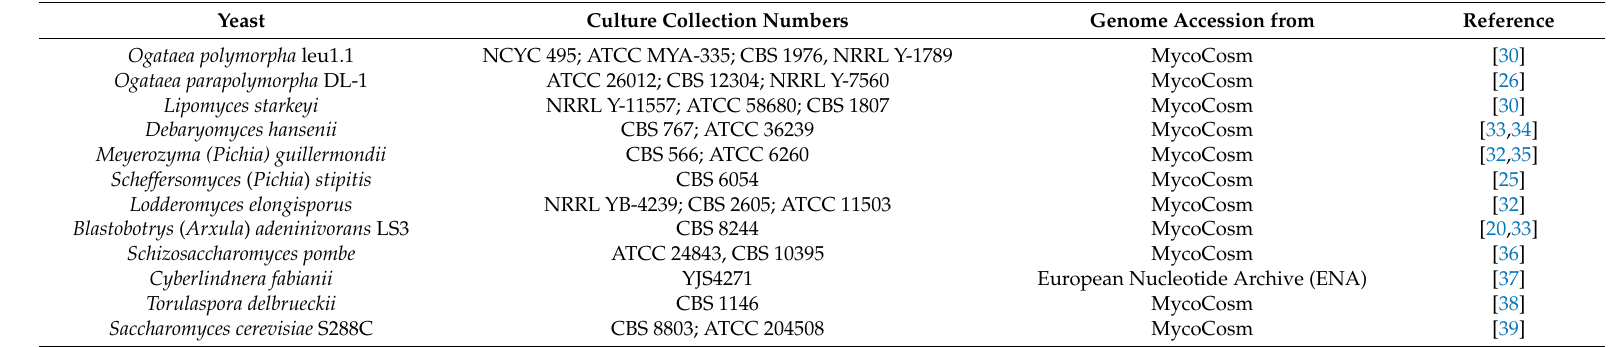
Table 1. Yeast strains and genomes analyzed in the current